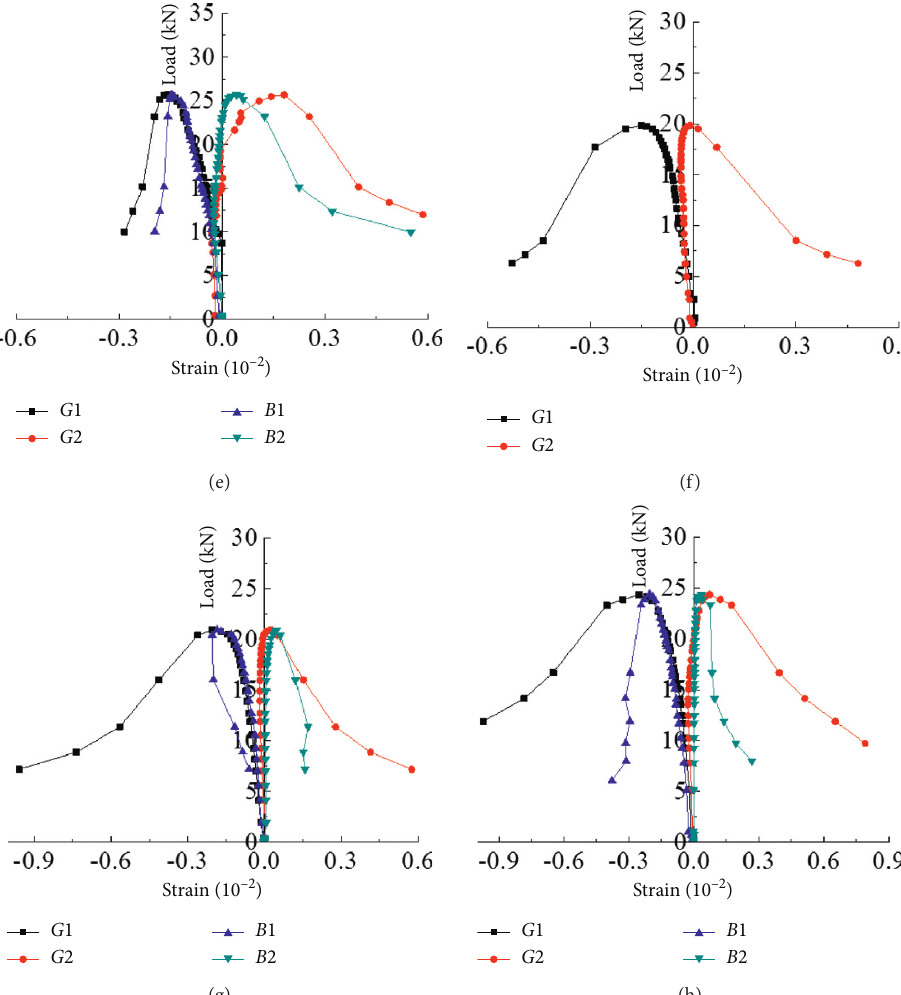
Figure 5: Strains of the specimens in Group 1. (a) JS000-11, (b) JW152-12, (c) JS000-13, (d) JS142-14, (e) JS152-15, (f) JS000-16, (g) JS142- 17, and (h)